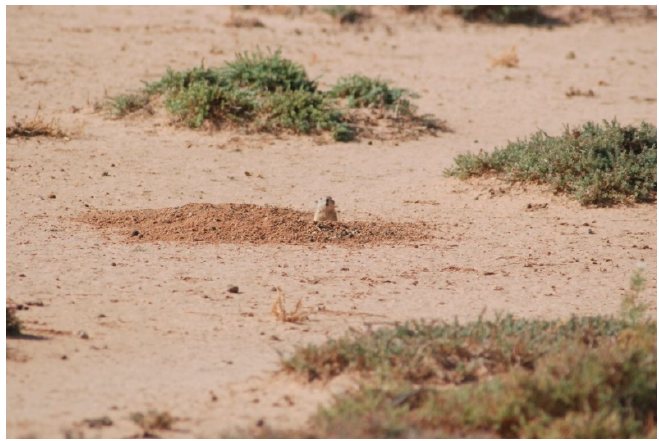
Figure 3. Psammomys obesus in its natural habitat (chenopod field; A).